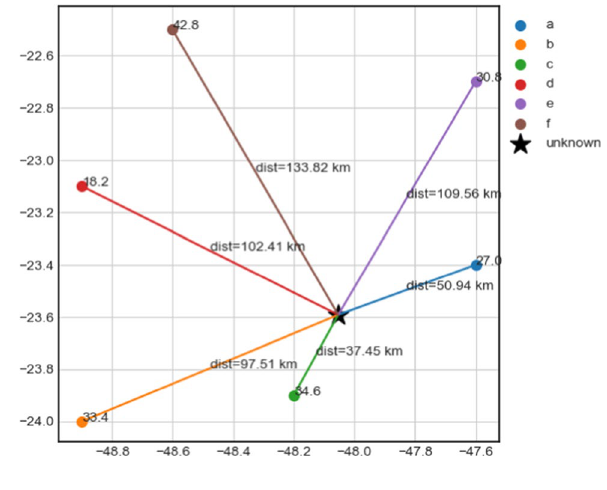
Fig. 6 IDW Principle